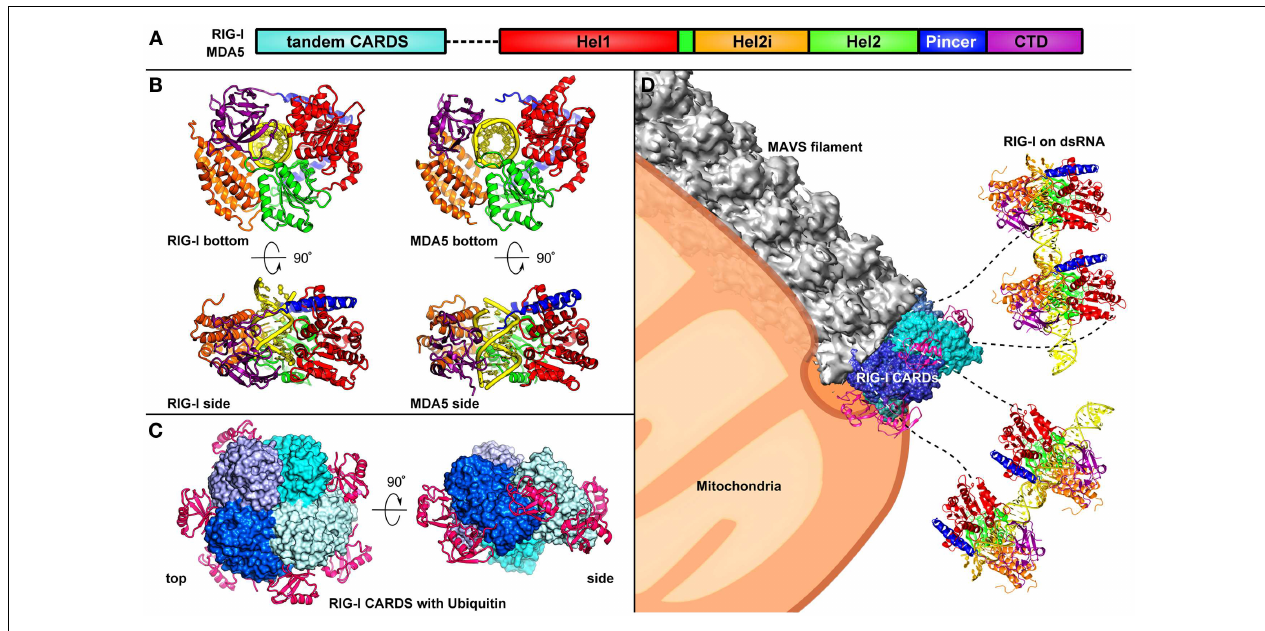
with three K63-di-ubiquitin molecules are shown (35). (D) RIG-I recognizes viral dsRNA in the cytosol and undergoes a conformational change, releasing the CARDs from an auto-repressed state. Four RIG-I molecules come together and their CARDs assemble into an oligomer stabilized by unanchored K63-linked polyubiquitin chains.The RIG-I CARDs serve as a scaffold for MAVS, which forms a filament that is tethered on the mitochondrial or peroxisomal membrane